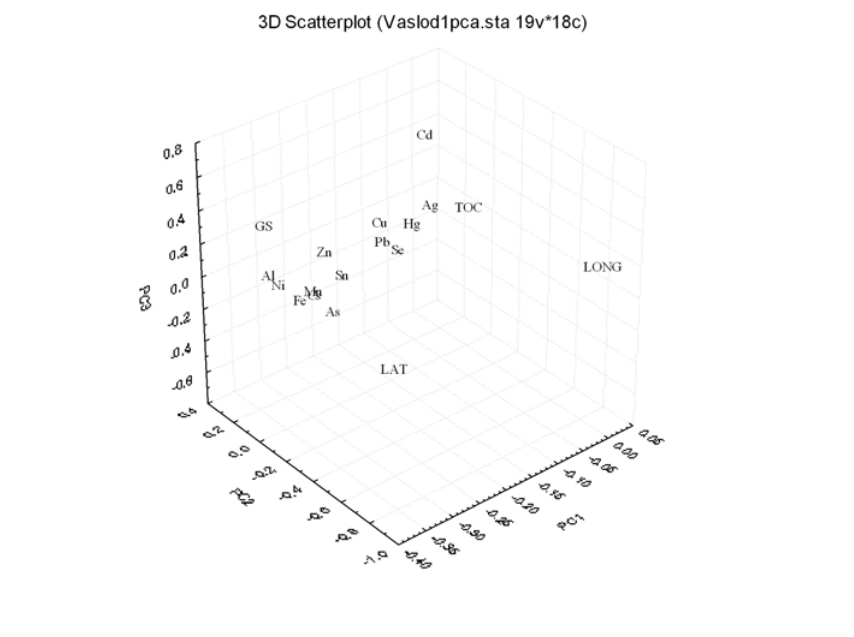
Fig. 2 Scatter plot of loadings corresponding to the first three principal components (Fuzzy PCA, first